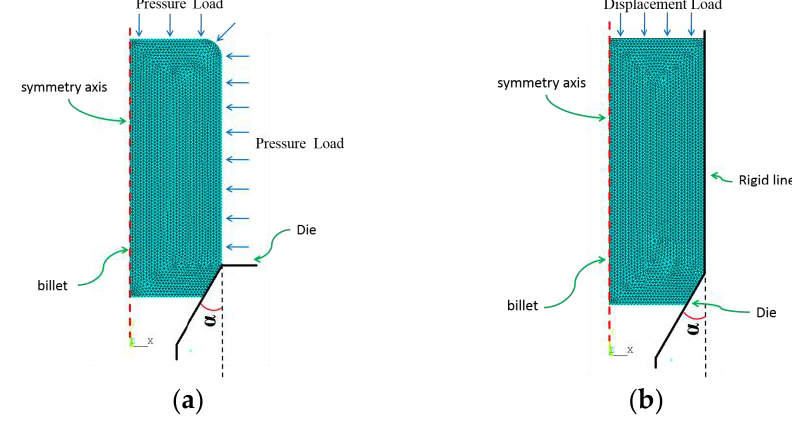
Figure 2. Models of ( a ) pressure load and ( b ) displacement load. Table 1. Material properties of AA2024.